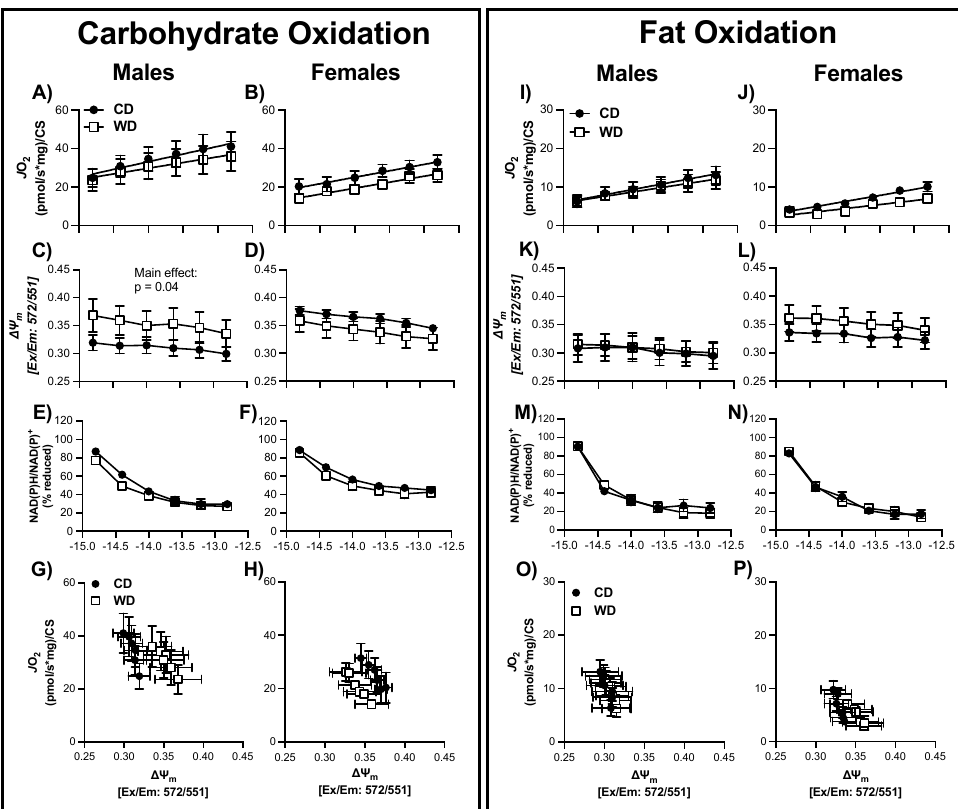
Figure 6. Respiratory control in male and female hippocampal mitochondria following consumption of a Western (WD) or chow (CD) diet. Changes in mitochondrial respiration ( J O 2 ) ( A , B ), membrane potential ( ∆ψ ) ( C , D ), and NADH reduction state (NAD(P)H/NAD(P)+) ( E , F ) as a function of ATP free energy ( ∆ G ATP ) when carbohydrates are used as a fuel source. Relationship between mitochondrial J O 2 and ∆ψ in the presence of carbohydrate are shown in ( G , H ). Changes in mitochondrial respiration ( J O 2 ) ( I , J ), membrane potential ( ∆ψ ) ( K , L ), and NADH reduction state (NAD(P)H/NAD(P)+) ( M , N ) as a function of ATP free energy ( ∆ G ATP ) when fats are used as a fuel source. Differences were analyzed by two-way ANOVA with factors for diet (CD vs. WD) and ATP free energy. Relationship between mitochondrial J O 2 and ∆ψ in the presence of carbohydrate are shown in ( O , P ). Main effects are noted in the absence of significant interactions ( p < 0.05).